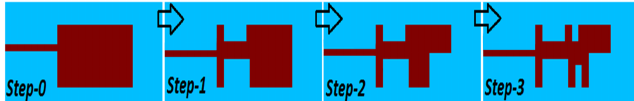
Figure 2. Proposed antenna element: design evaluation steps.